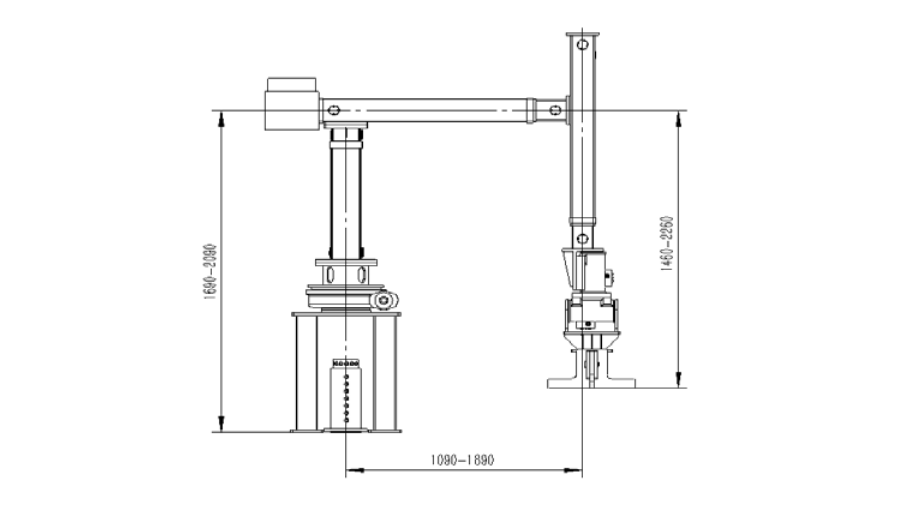
Fig. 5. The structural shape of the